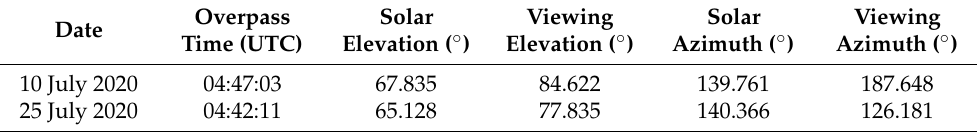
Table 7. Solar–target–satellite acquisition geometric conditions of the GF7 satellite at the Dunhuang site.